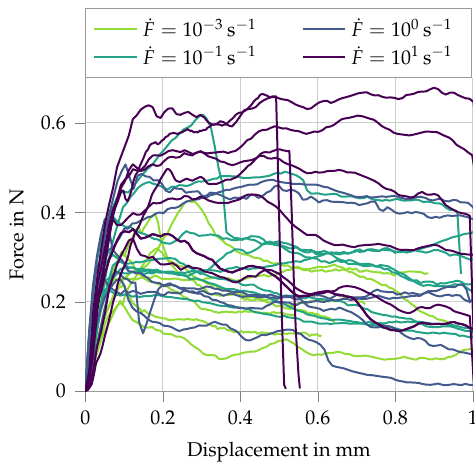
Figure 2. Results of PE fiber in pullout tests at different displacement/loading rates; data from